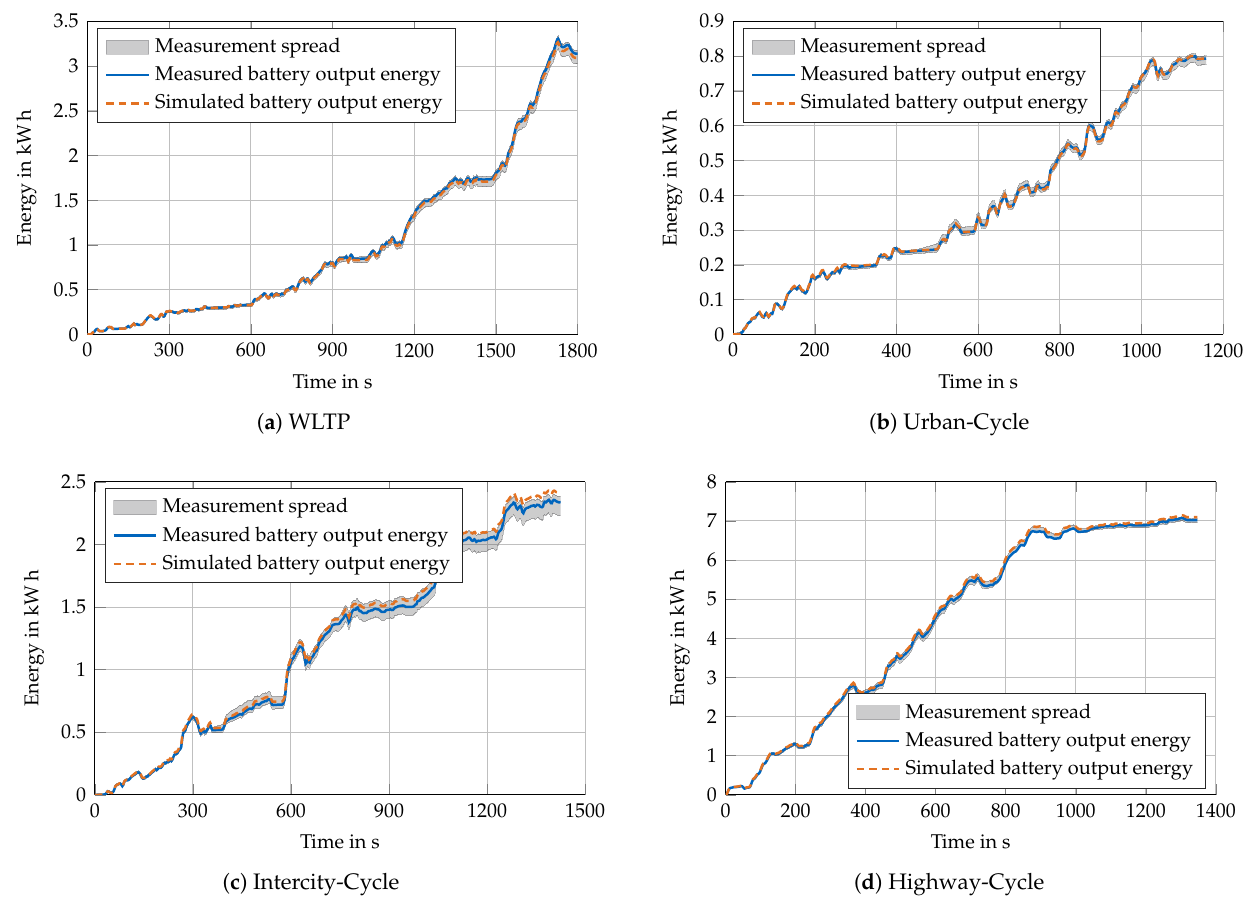
Figure 4. Battery output energy consumption of measurement data [61] and simulation for the 2nd run of the WLTP, urban, intercity, and